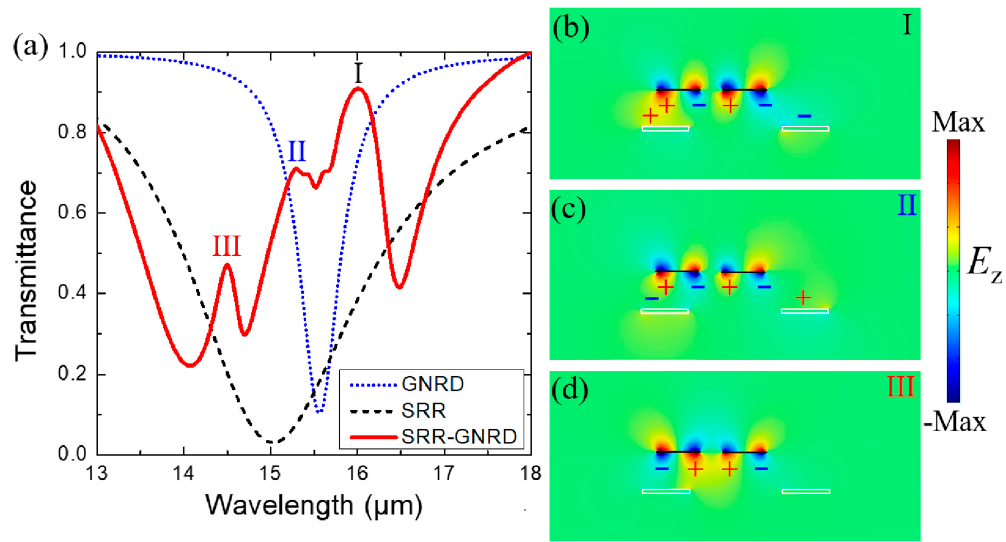
Figure 3. ( a ) Transmittance of the array of the hybrid graphene–metal metamaterial with the structural parameters d 1 , d 2 , and d 3 = 0.4, 0.6, and 0.4 μ m, respectively (red solid curve). The transmittance of the split-ring resonator (SRR) (black dashed curve) and GNRD (blue dotted curve) is also shown. ( b – d ) Simulated normalized electric field distributions of E z and the surface charge distribution from the front view (in xz plane) for each plasmon mode (I, II, and III) shown in ( a ). I, II, and III represent the electric dipole in-phase bonding dark mode, out-of-phase bonding dark mode, and antibonding dark mode, respectively.